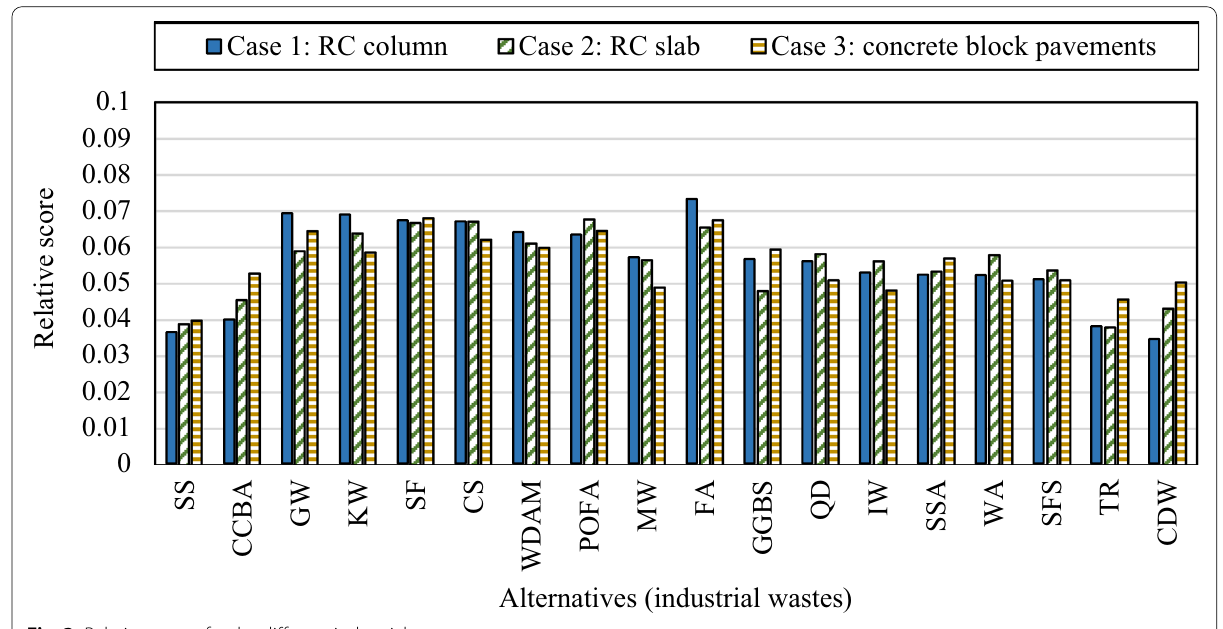
Fig. 3 Relative scores for the different industrial wastes.